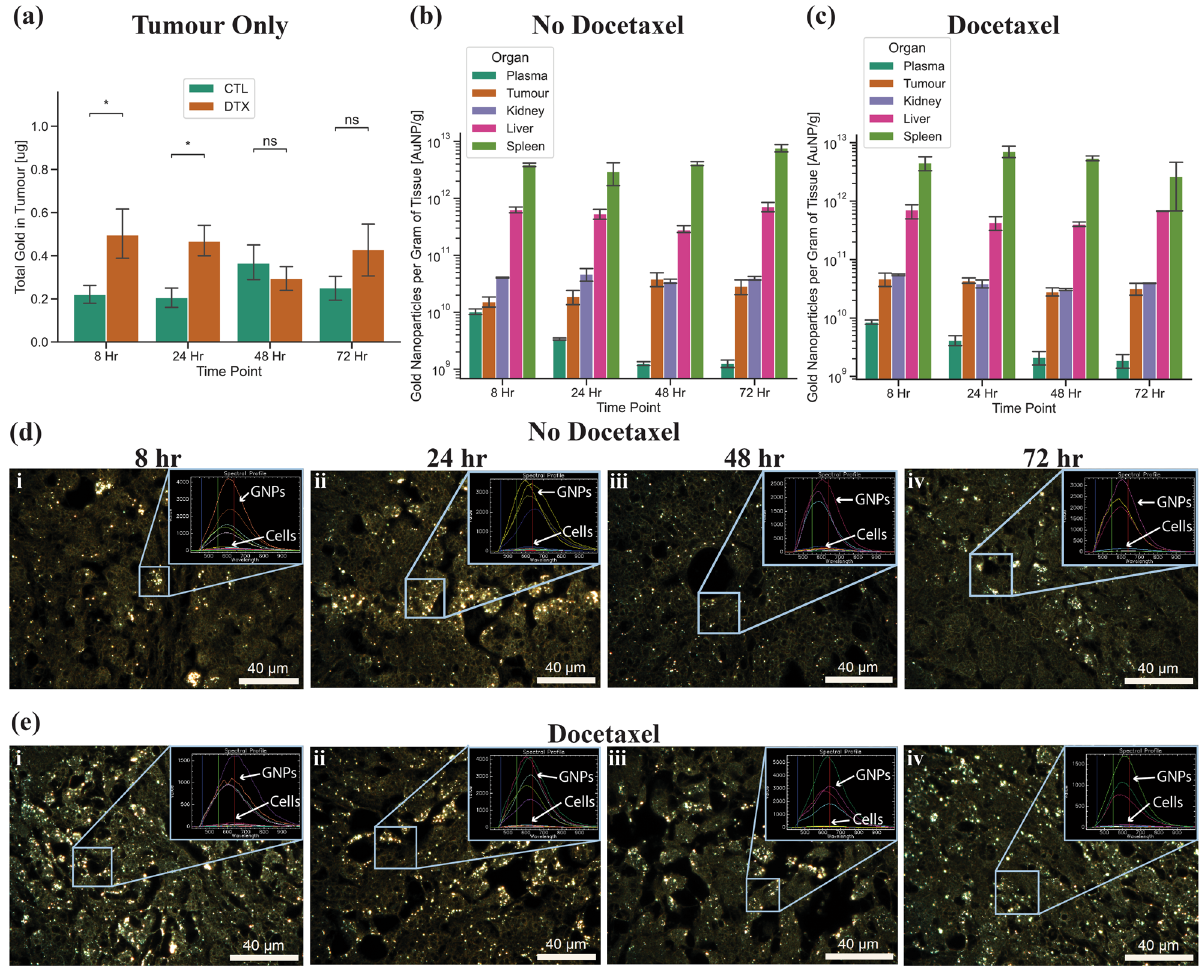
Figure 6. Gold nanoparticle uptake in in vivo mouse xenograft model. ( a ) Total gold uptake in the tumour after 8, 24, 48, and 72 h for tumours treated with gold or treated with gold and docetaxel. DTX refers to docetaxel treated samples and CTL refers to control samples with no docetaxel. ( b , c ) Total gold nanoparticles per gram of tissue for plasma, tumour, kidney, liver, and spleen after treatment ( b ) without docetaxel and ( c ) with docetaxel, after 8, 24, 38, and 72 h. Error bars are the 95% confidence interval from four independent mice. ns indicates no significance, * indicates 0.01 < p < 0.05. ( d , e ) Darkfield images of 5 µm sections of tumour tissue 8, 24, 48, and 72 h after ( d ) gold nanoparticle treatment and after ( e ) concurrent gold nanoparticle and docetaxel treatment. Inset is hyper spectral spectrum of gold nanoparticles and cells. Scale bar is 40